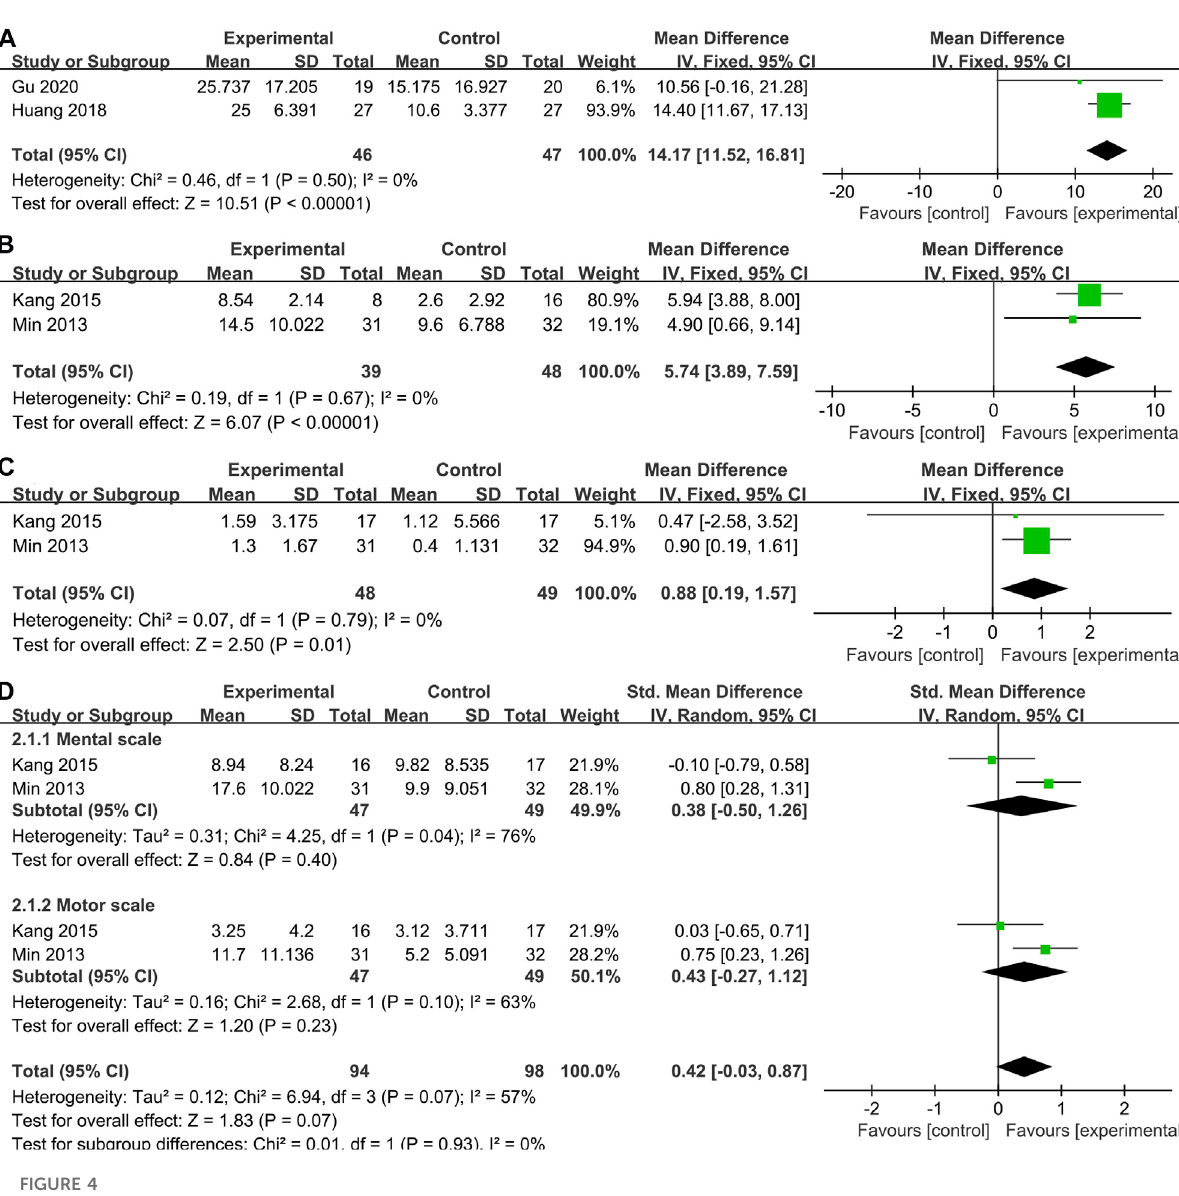
Secondary indicators. Forest plot demonstrating the effect of stem cells compared with controls on (A) CFA, (B) GMPM, (C) WeeFIM and (D) BSID- Ⅱ